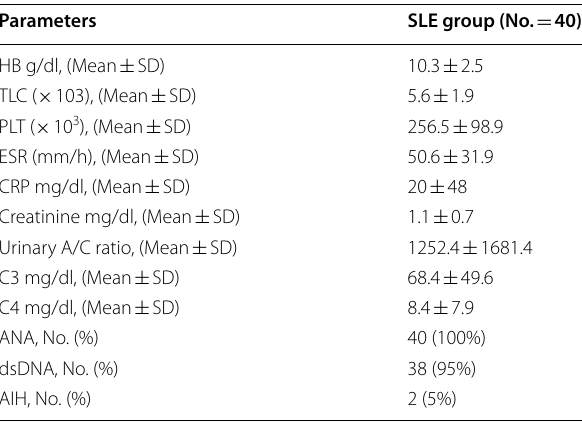
A/C ratio albumin/creatinine ratio; AIH autoimmune hemolytic anemia; ANA antinuclear antibody; anti dsDNA anti-double-stranded DNA antibody ; C3 C3 complement fraction; C4 C4 complement fraction; CRP C - reactive protein; ESR erythrocyte sedimentation rate